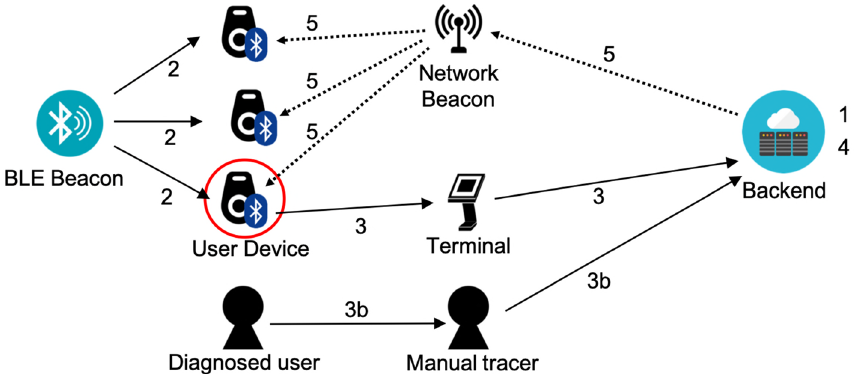
Figure 1. PanCast’s architecture. 1. Beacons and user devices are registered with the backend. 2. User devices record encounters with BLE beacons. 3. Diagnosed users or healthy volunteers may upload their history of encountered beacons to the backend via a terminal. 3b. Optionally, health workers can manually feed inputs from users into the backend system. 4. The backend updates the risk database with uploaded encounters. 5. Risk information is periodically broadcast from the backend to network beacons, which broadcast the information to nearby user